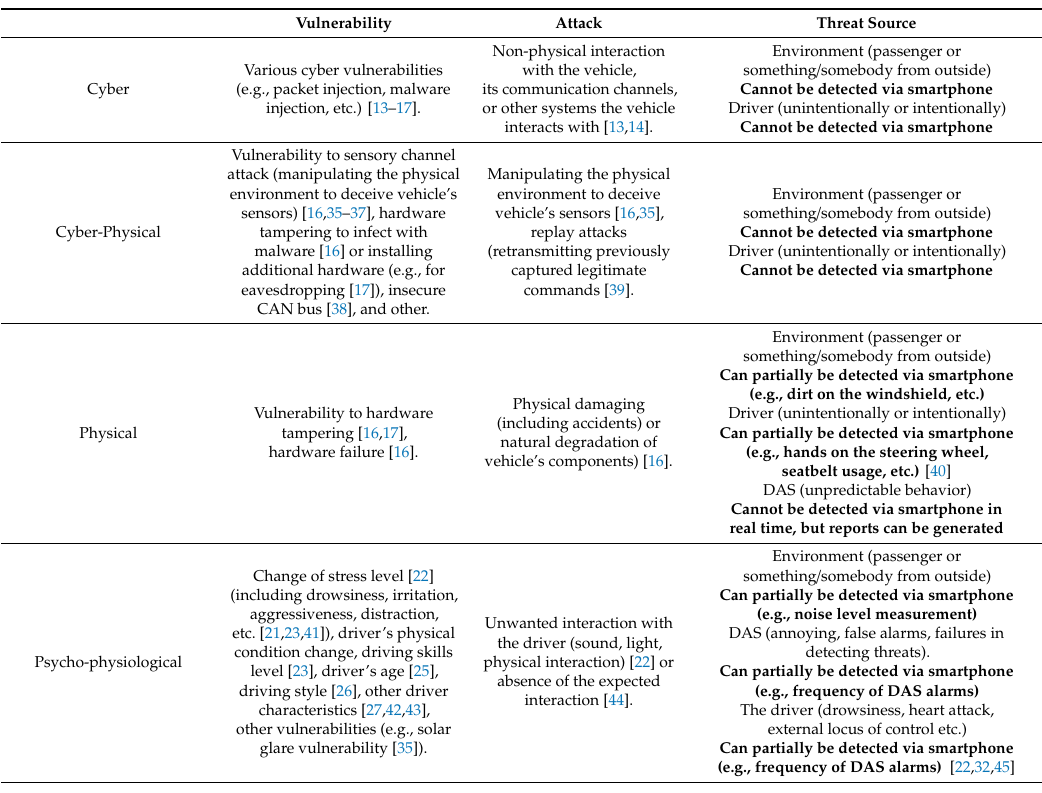
Table 2. Vulnerabilities, attacks, and associated threats detectable by smartphone